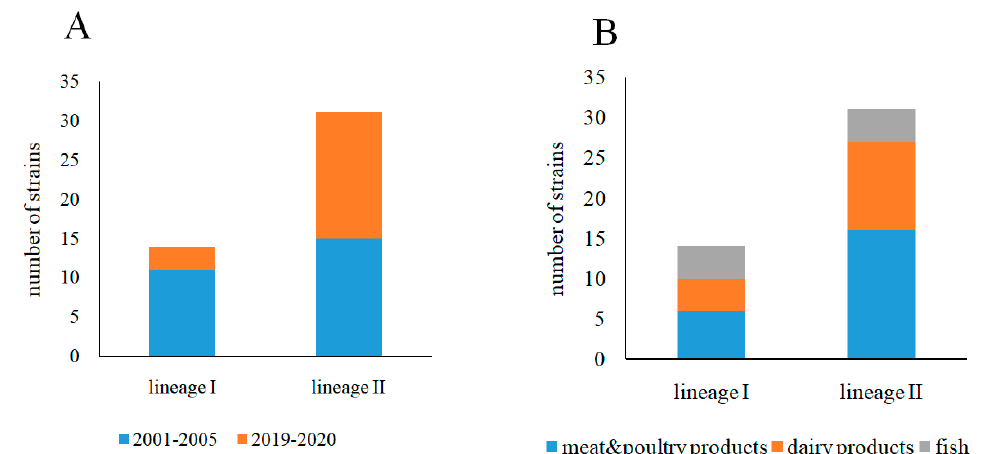
Figure 2. Representation of lineage I and lineage II strains. ( A )—Among isolates obtained in 2001– 2005/2019–2020 years; ( B )—among isolates obtained from different food